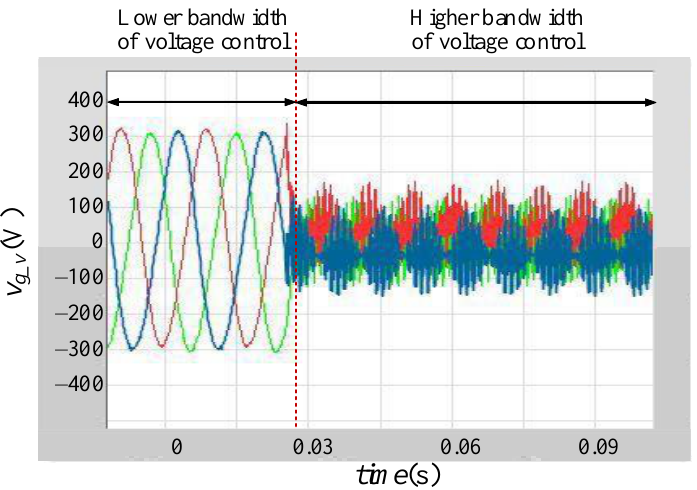
Figure 8. The closed-loop voltage control under the unstable region when v dref is 311 V.